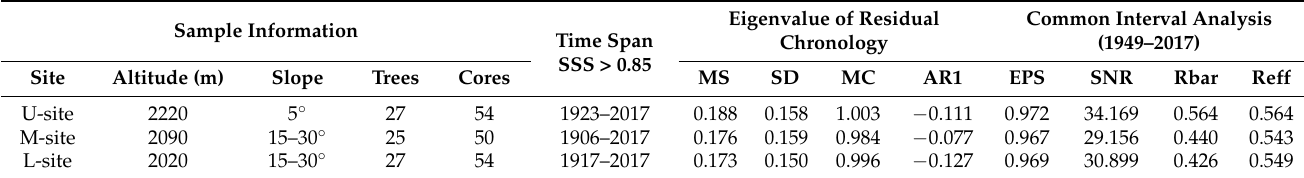
Table 1. Chronology statistics for residual chronologies of Picea wilsonii in Mt. Guandi, Central China. Sample Information Time Span SSS >